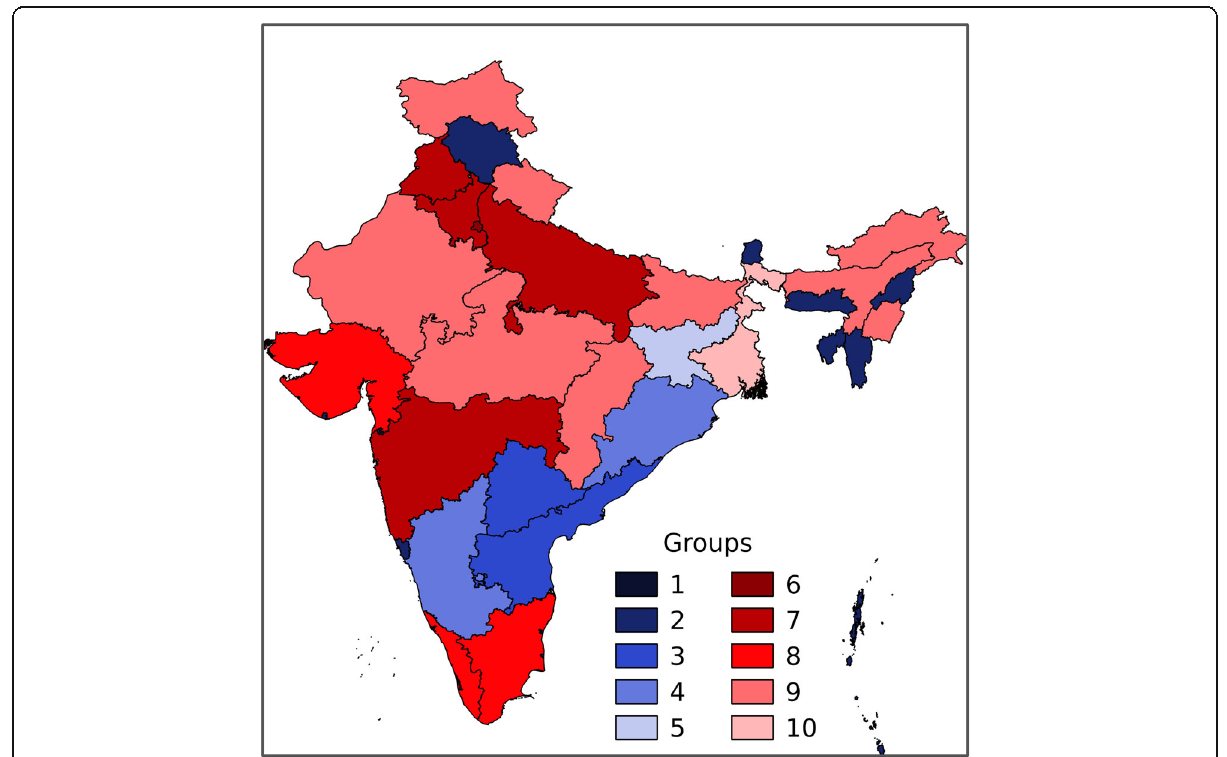
Fig. 5 The correlation analyses provided a basis for identifying states and territories exhibiting the strength of correlations between numbers of dengue cases and numbers of news articles for those places. Groups 1 to 5 exhibit poor correlations (blue colors). Groups 6 to 10 exhibit strong correlations (red